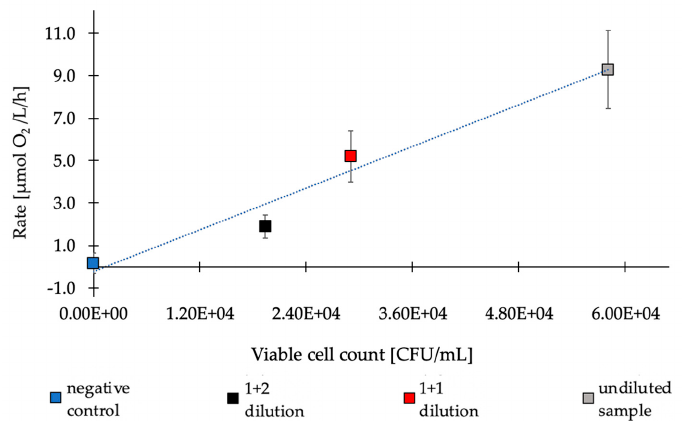
Figure 6. Correlation between the numbers of colony forming units (CFUs) in samples measured by plate counts and the oxygen consumption rates measured by the optode system. Data points represent means with the respective standard deviations for each sample (n = 5 for the undiluted sample, 2 for 1 + 1 and 1 + 2 dilutions and 3 for the negative control). The linear regression shown by the blue dotted line has an R 2 = 0.9648.